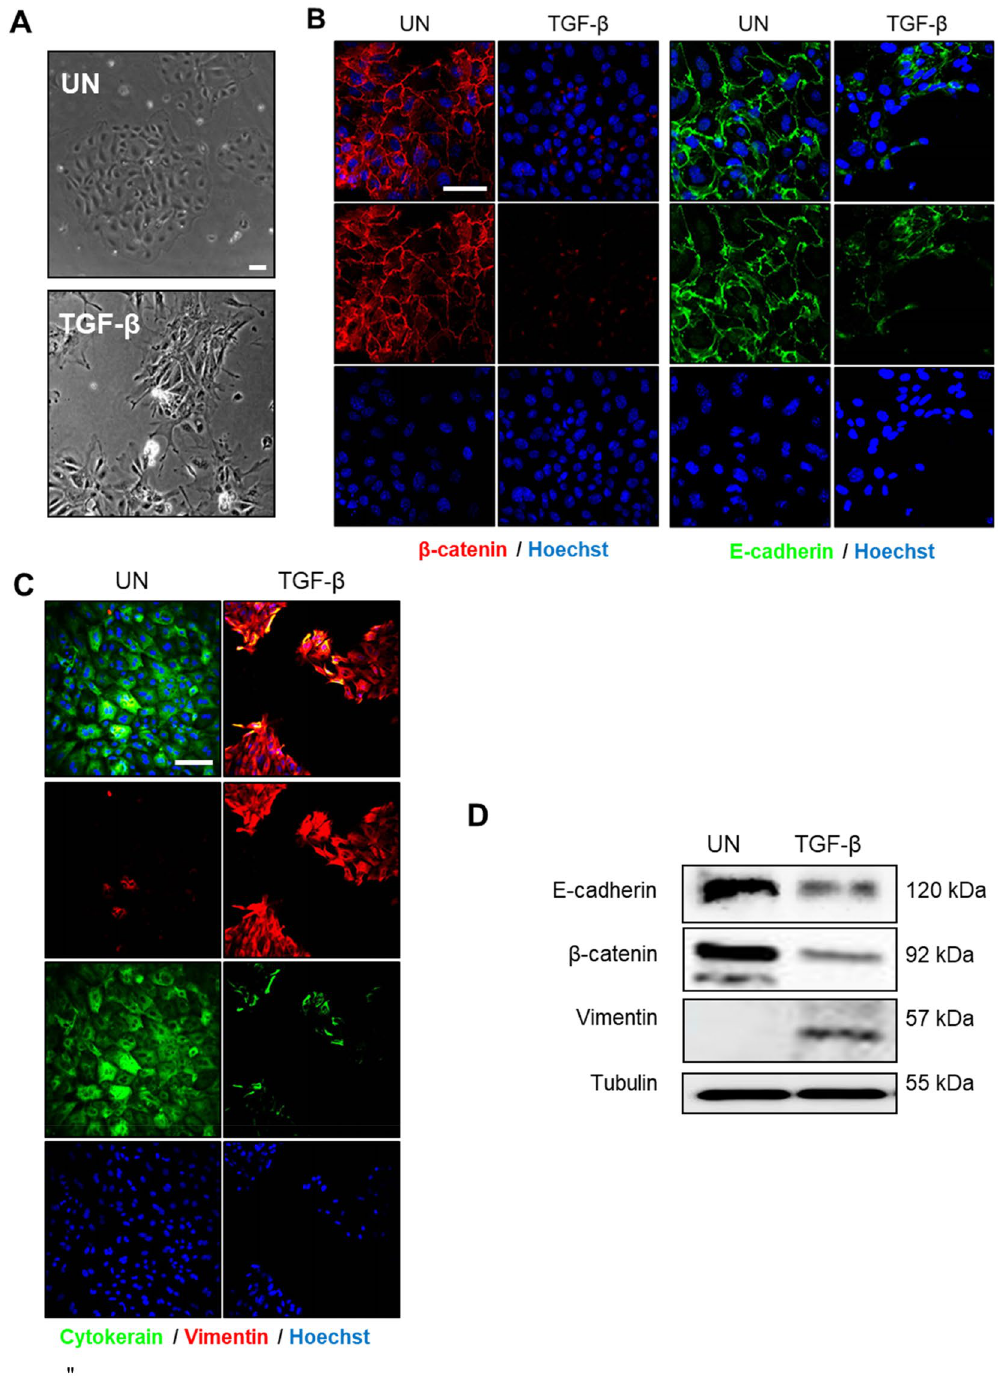
Figure 3. ( A ) Phase contrast images of 2D endometrial epithelial monolayers untreated (UN) or treated for 72 h with TGF-β 20 ng/ml. ( B ) Representative confocal images of β-catenin and E-cadherin immunofluorescences corresponding to 2D endometrial epithelial monolayers untreated (UN) or treated for 72 h with TGF-β 20 ng/ml. Cells were counterstained with Hoechst to visualize nuclei. Scale bars: 25 µm. ( C ) Representative confocal images of double cytokeratin and vimentin immunofluorescence of 2D endometrial epithelial monolayers untreated (UN) or treated for 72 h with TGF-β 20 ng/ml. Cells were counterstained with Hoechst to visualize nuclei. Scale bars: 25 µm. ( D ) Western blot analysis of E-cadherin, β-catenin and vimentin expression on lysates obtained from 2D monolayer stimulated for 72 h with TGF-β 20 ng/ml. Membrane was re-blotted with tubulin to check for equal protein